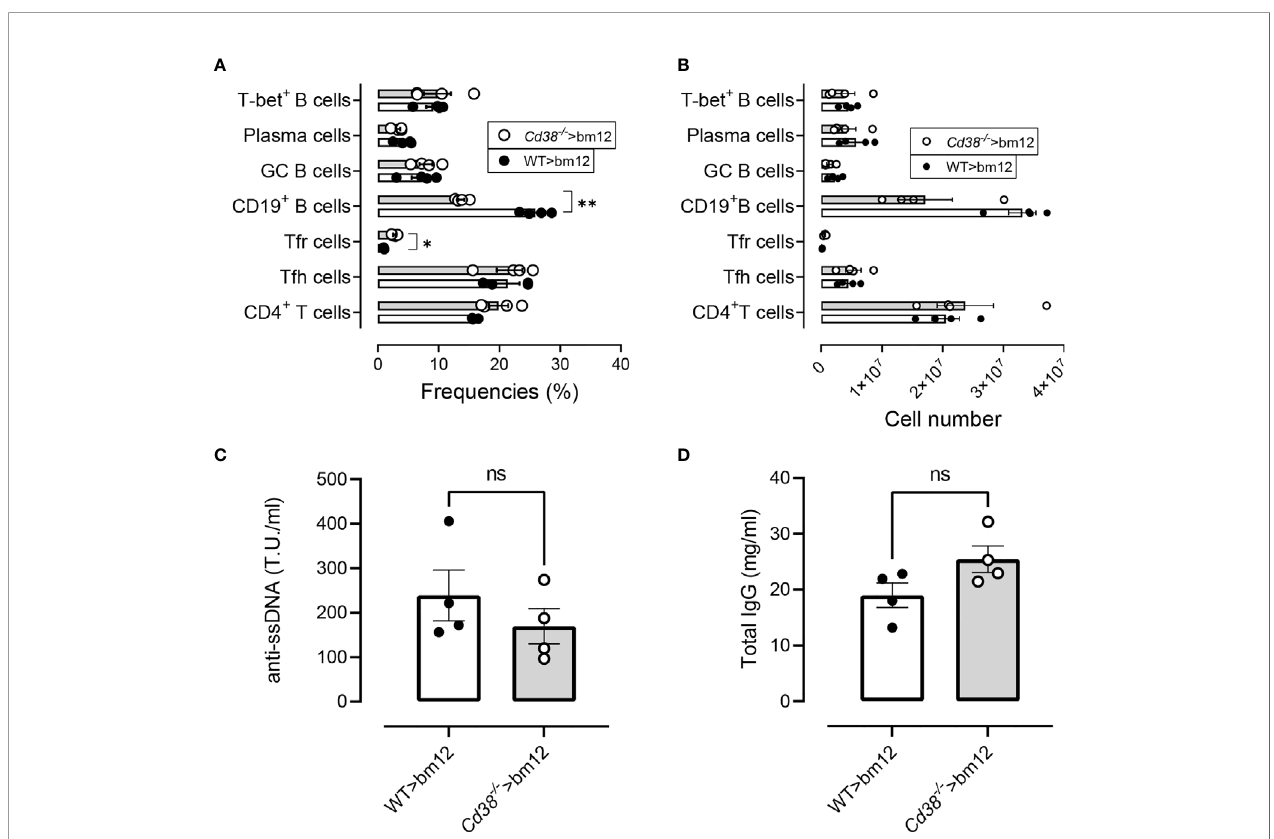
FIGURE 12 | Normal cGVHD response in bm12 mice after the adoptive transfer of Cd38 − / − spleen cells. (A) Frequencies of the T- and B-cell subsets analyzed in WT>bm12 mice (closed circles and open bars) and Cd38 − / − >bm12 mice (open circles and gray bars), 2 weeks after the adoptive transfer of cells. (B) Total numbers of the same subsets and mice of panel (A) . (C) Anti-ssDNA serum levels. (D) Total IgG serum levels. Data in (A – D) are from one out of two independent experiments, each symbol representing one mouse. In (A, B) , P -values are for multiple t -tests corrected for multiple comparisons by the Holm – S ̌ ida ́ k method. In (C, D) , the P -values are for unpaired t -test. ns, not signi fi cant ( P > 0.05), * P < 0.05, **P <